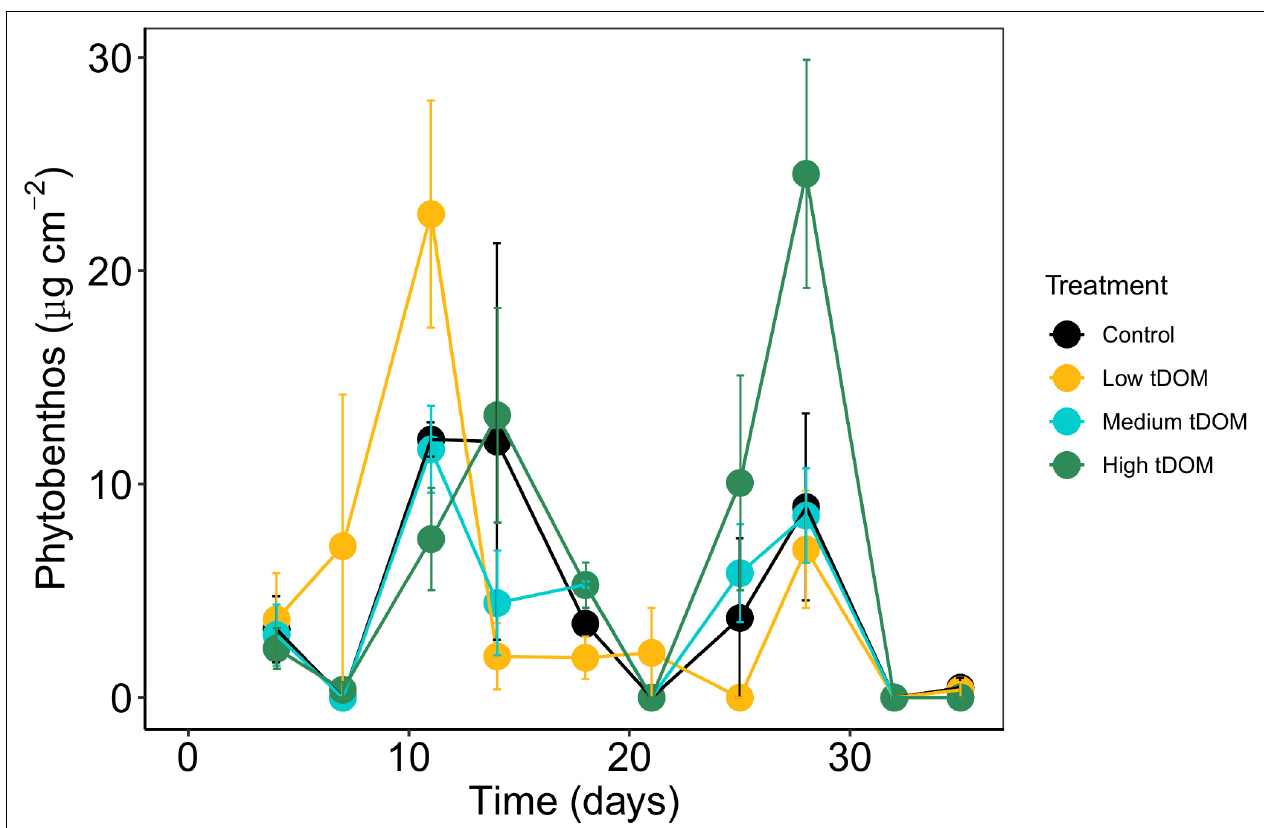
FIGURE 5 | Average of phytobenthos biomass (Chl a in µ g cm − 2 ) over 35 days of the experiment. Error bars represent standard deviation. Color plots represent tDOM addition in the control (black), low tDOM (yellow), medium tDOM (blue), and high tDOM (green)